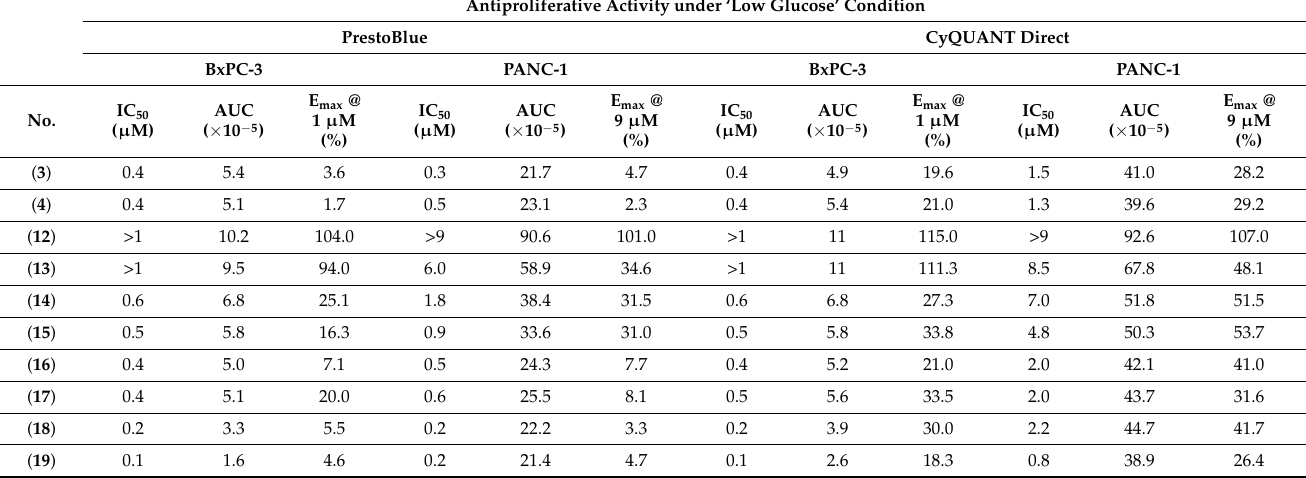
Table 1. Drug response metrics table (IC 50 , AUC, and E max ) of trichoderin A ( 3 ) and its analogues ( 4 ) , ( 12 )–( 19 ) against BxPC-3 and PANC-1 cells cultured under ‘low glucose’ condition, as judged by the PrestoBlue™ and CyQUANT™ Direct assays. All values are shown in 1 decimal place (d.p.). The most active entry in the series is highlighted in yellow.